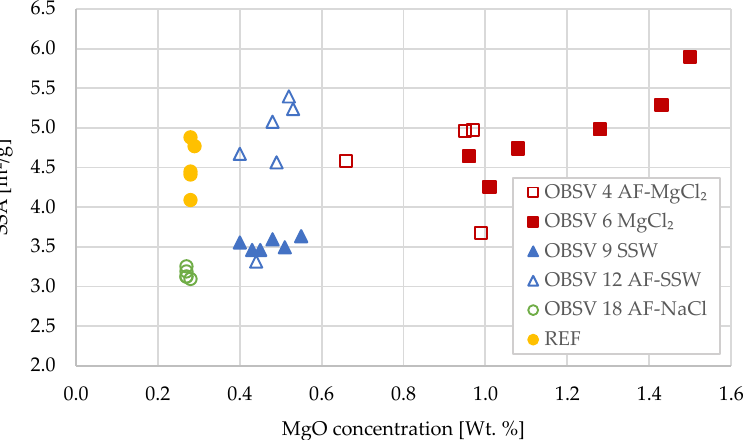
Figure 10. A presentation of the link between precipitation of MgO and SSA for all flooded samples compared with unflooded reference samples.